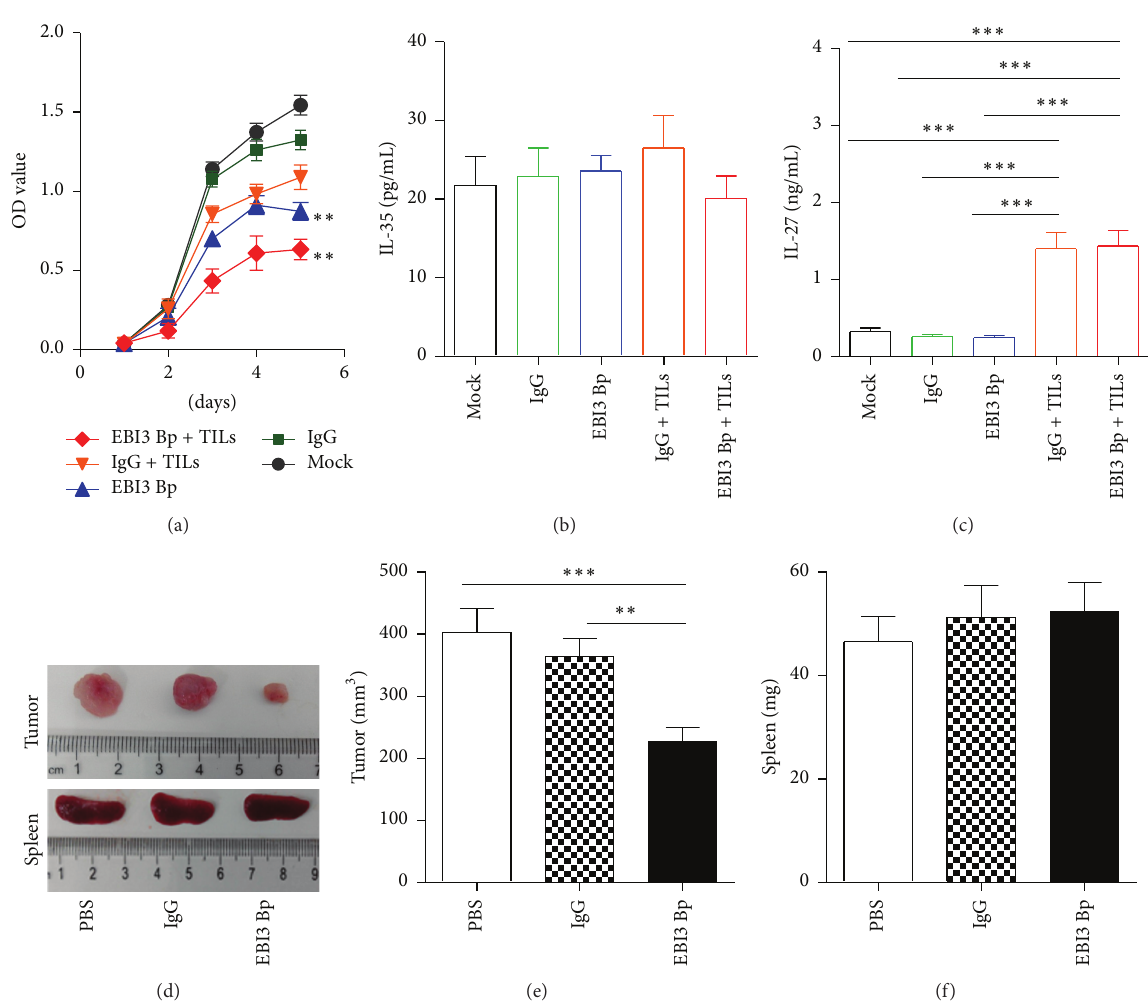
Figure 4: Assessing the role of EBI3 blocking in CRC cell proliferation and tumor growth in vitro and in vivo. (a) CRC cell proliferation after stimulation with EBI3 Bp or coculture with autologous TILs was detected by CCK-8, an isotype IgG, and PBS for control. (b) Supernatants IL-35 levels were detected by ELISA. (c) Supernatants IL-27 levels were detected by ELISA. (d) Representative images of the tumors and spleens at the endpoint from tumor xenograft models. (e) Tumor volumes were measured at the endpoint. (f) Spleens weight was measured at the endpoint. Significant decrease in tumor size but not spleens weight was observed in mice treated with EBI3 Bp as compared to those of control mice. ∗∗ 𝑃 < 0.01 ; ∗∗∗ 𝑃 < 0.001